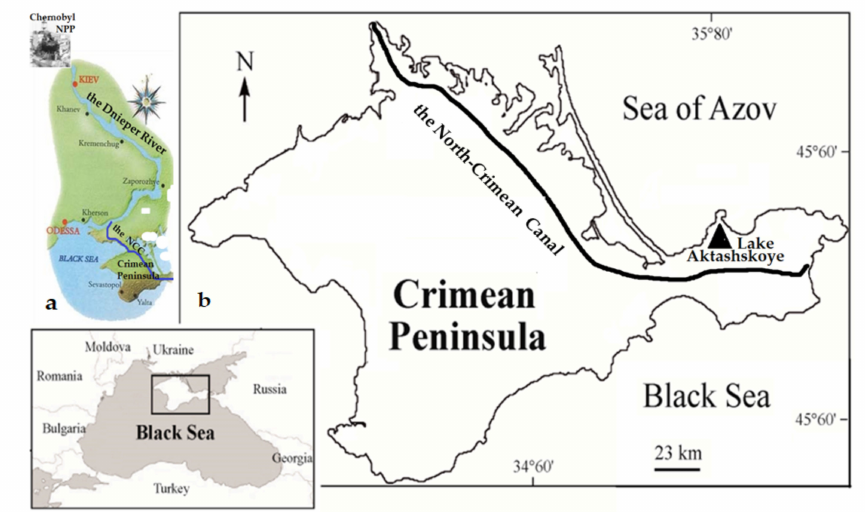
Figure 1. Map scheme location of the Chernobyl NPP area, showing the Black Sea and the Crimean Peninsula ( a ), the position of Lake Aktashskoye, and the NCC on the territory of Crimea ( b ). The length of the lake is 8 km, the average width is 3.0 km, the maximum is 3.5 km, the depth is 2 m, and the maximum is 3 m. The surface area of the lake is 26.8 km 2 , and the drainage basin is 467 km 2 . Lake Aktashskoye is a marine salt lake, and salinity in it is characterized by high spatial and temporal variability, from 10 to 280 g L − 1 .